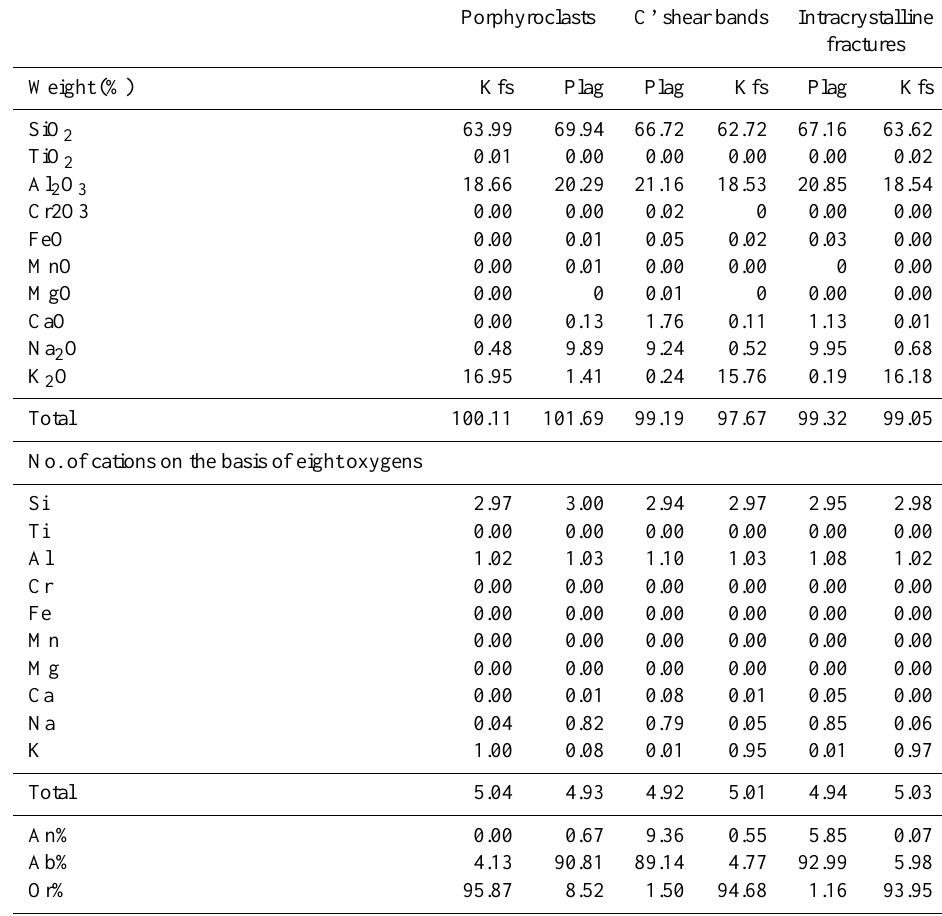
Porphyroclasts C’ shear